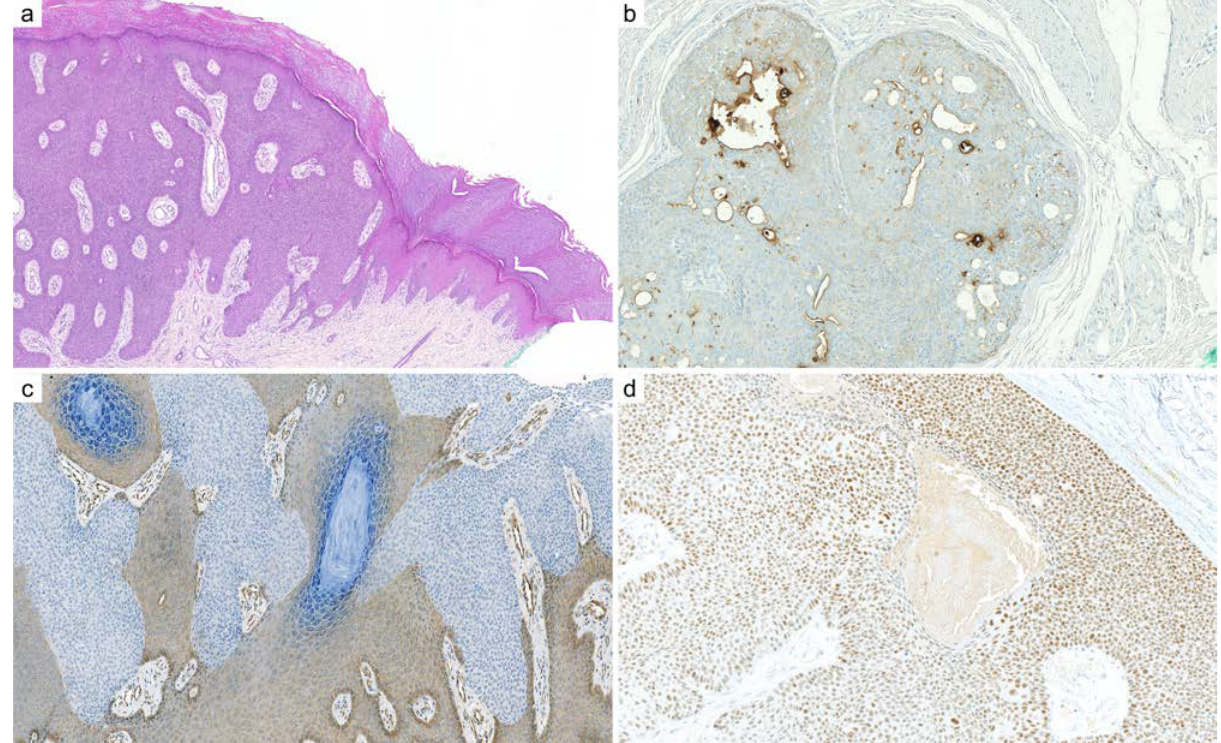
Figure 6. Eccrine poroma: ( a ) cutaneous eccrine poroma is composed of a population of poroid cells, with a sharp demarcation with adjacent epidermis, inconspicuous ducts, and numerous dilated vessels in the papillary dermis ( × 25); ( b ) CEA immunohistochemistry highlights the ductal differentiation ( × 200); ( c ) YAP1 (c-terminal) immunohistochemistry shows a clonal loss of expression in poroid cells compared to the adjacent epidermis, which suggest a YAP1 -fusion ( × 200); ( d ) NUT immunohistochemistry demonstrates diffuse nuclear staining when a NUTM1 gene fusion is involved, which is more frequent in the poroid hidradenoma variant ( ×